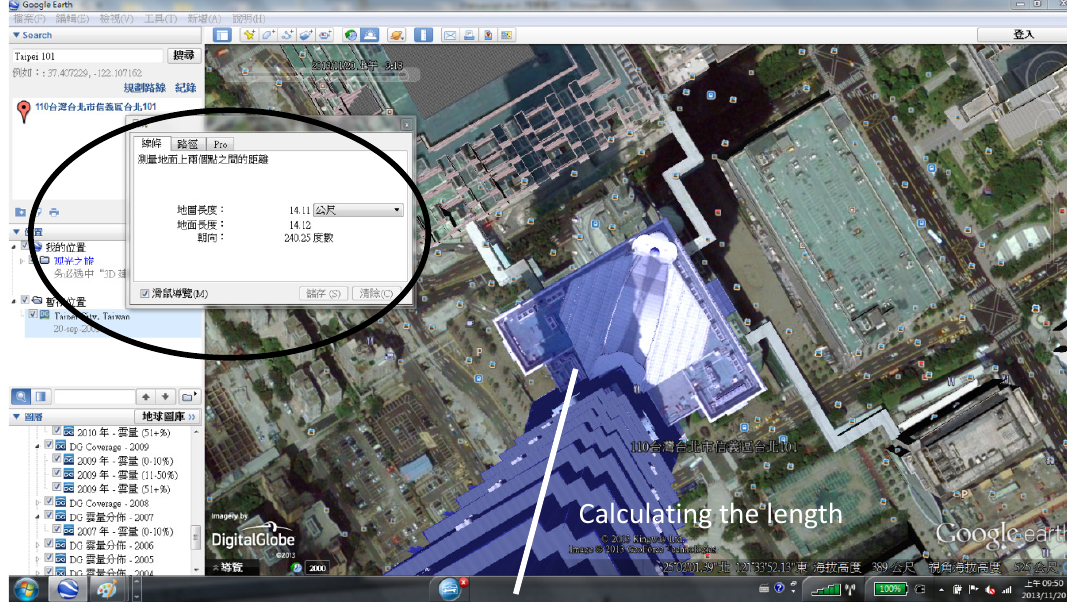
Figure A5. Using tool box to calculate length on Digital Global view.